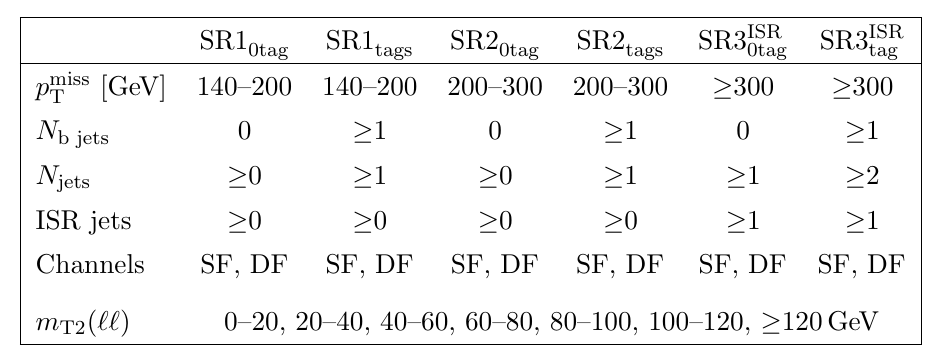
Table 2 . De(cid:12)nition of the SRs for the chargino search as a function of the p miss jet multiplicity and jet multiplicity. Also shown are the CRs with b-tagged jets used for the normalization of the tt and tW backgrounds. Each of the regions is further divided in seven m T2 ( ‘‘ ) bins as described in the last row.